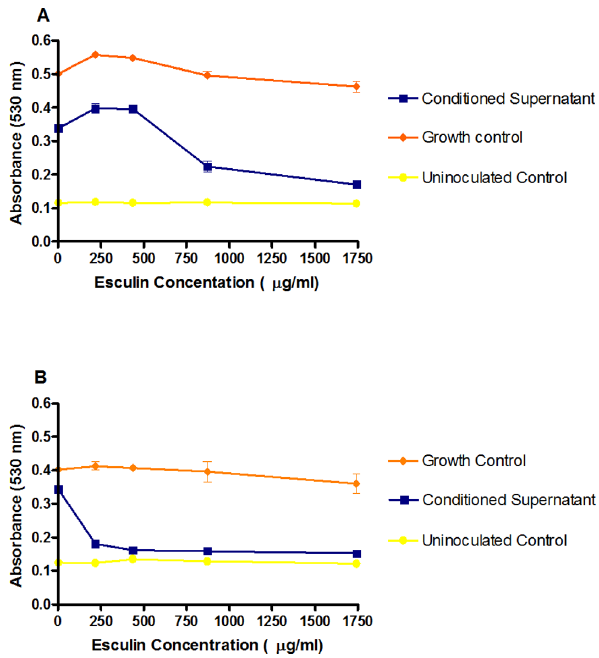
Figure 3. Analysis of the effect of 8 week old conditioned supernatants on the antifungal activity of esculin. Conditioned supernatants were used against T. rubrum NCPF0118 (A) and T. interdigitale NCPF0335 (B) grown for 7 d at 30 u C. All results are representative of triplicate samples from triplicate experiments. Error bars represent the standard deviation of the mean.